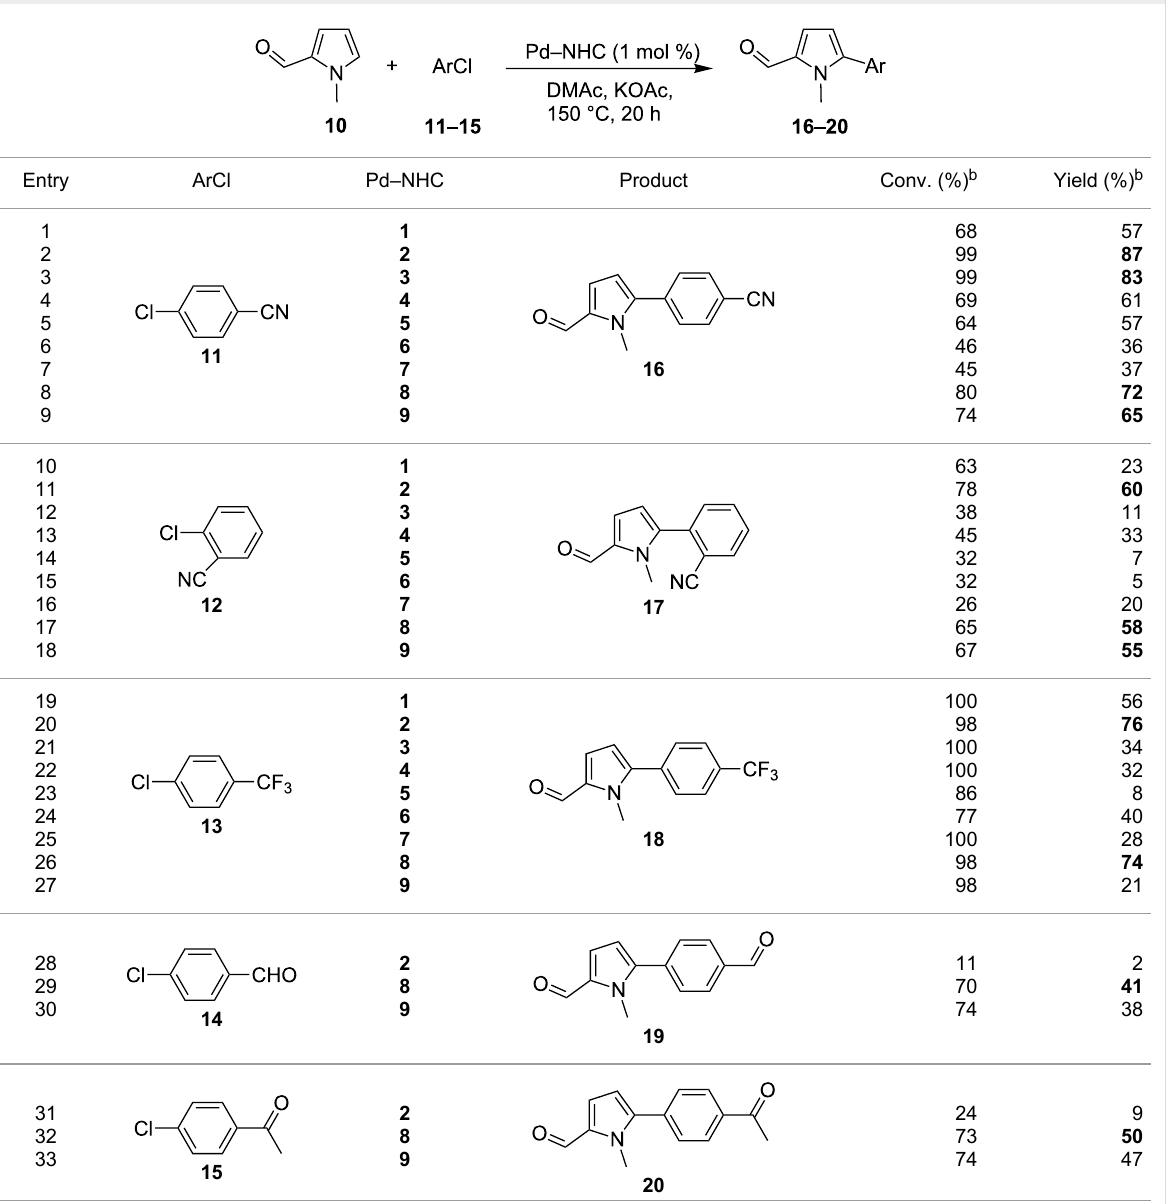
Table 1: Direct arylation of 1-methylpyrrole-2-carboxaldehyde ( 10 ) with chlorobenzene derivatives.